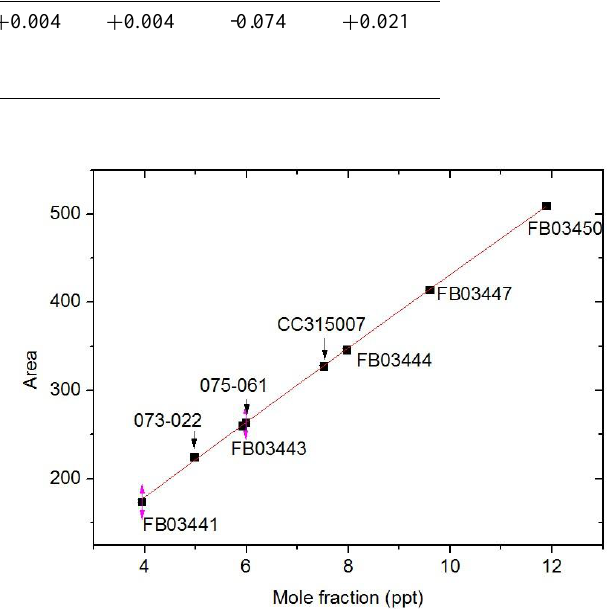
Fig. 6. Responses of working standard (CC315007, in air) prepared Figure 6 Responses of working standard (CC315007, in air) prepared at WCC-SF 6 and 3 at WCC-SF 6 and KRISS gravimetric standards (073-022 and 075- KRISS gravimetric standards (073-022 and 075-061, both in nitrogen). KRISS standards are 4 061, both in nitrogen). KRISS standards are biased by 0.13ppt from WMO scales due to the matrix biased by 0.13 ppt from WMO scales due to the matrix effect. 5